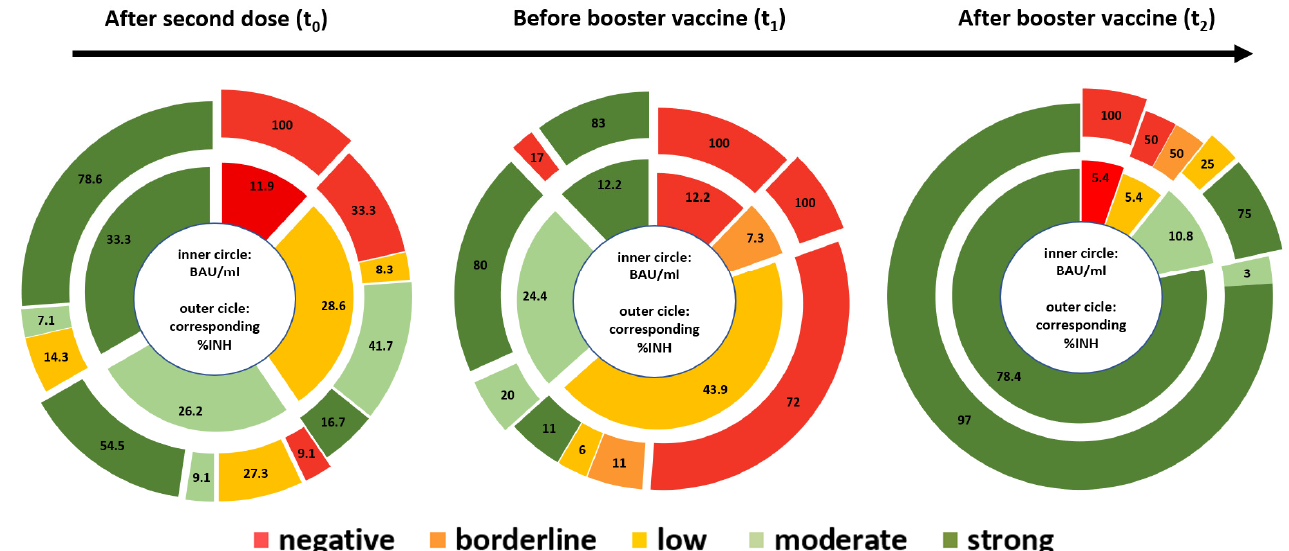
Figure 4. Fraction of neutralizing capacity for different antibody levels. The inner circle is showing levels of antibody response (BAU/mL) with the corresponding percentage of neutralizing antibodies (%-INH) in the outer circle for t 0 , t 1 and t 2 , respectively. Data are expressed as percentages. Applying the following antibody and SNA cut-off levels: negative (<7.1 BAU/mL or <30%-INH), border- line (>7.1–8.5 BAU/mL or >30–35%-IHN), low (>8.5–100 BAU/mL or >35–50%-INH), moderate (>100–500 BAU/mL or >50–70%-INH), strong (>500 BAU/mL or